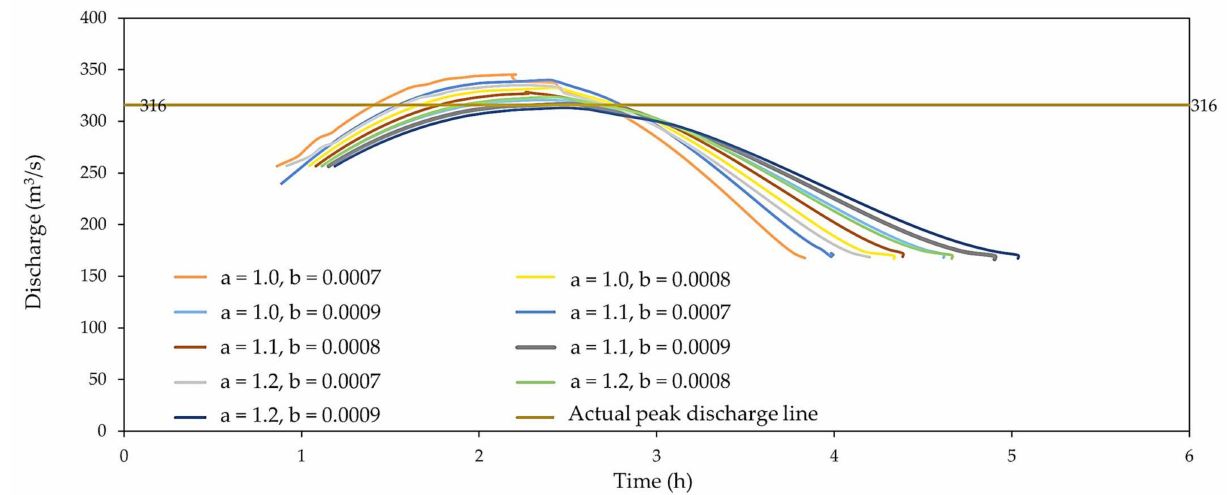
Figure 8. Simulated flow curve for the actual situation (S0) under different